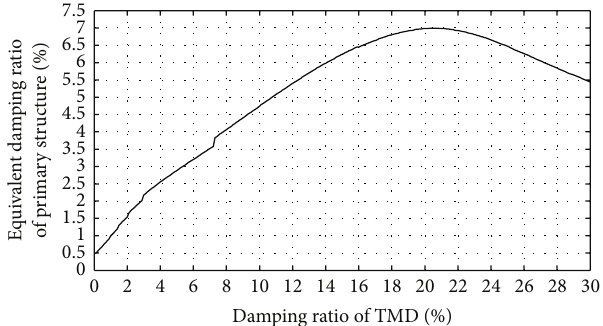
Figure 6: Damping ratios of the primary structure under different damping ratios of